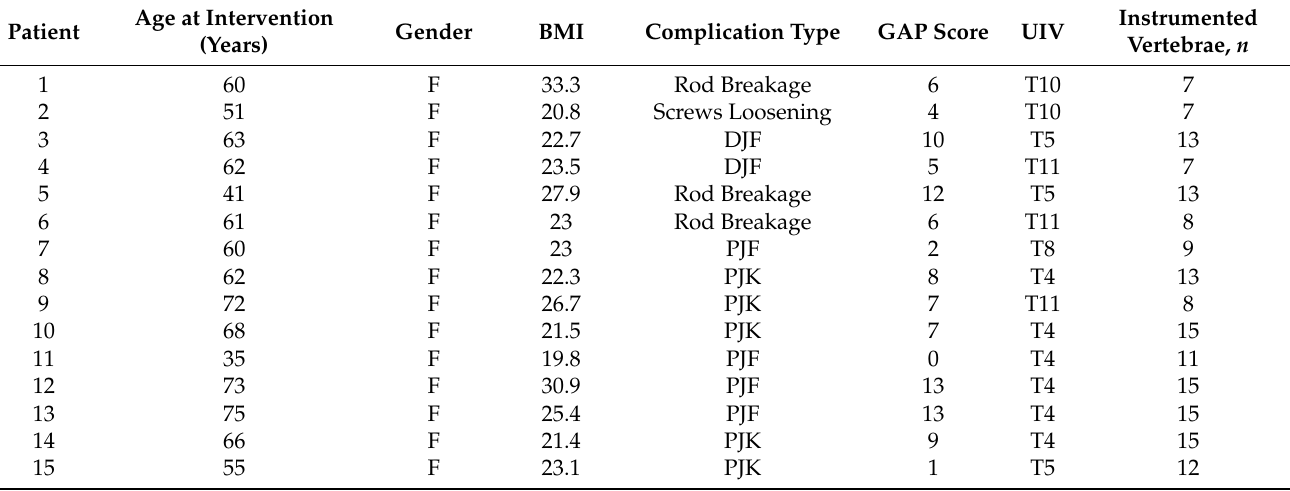
Table 6 shows demographic data and different parameters of patients with mechanical complications (Table 6). Table 6. Details for the 15 patients with mechanical complications. BMI, body mass index; DJF, distal junctional failure; PJF, proximal junctional failure; PJK, proximal junctional kyphosis; GAP score, Global Alignment and Proportion score; UIV, upper instrumented